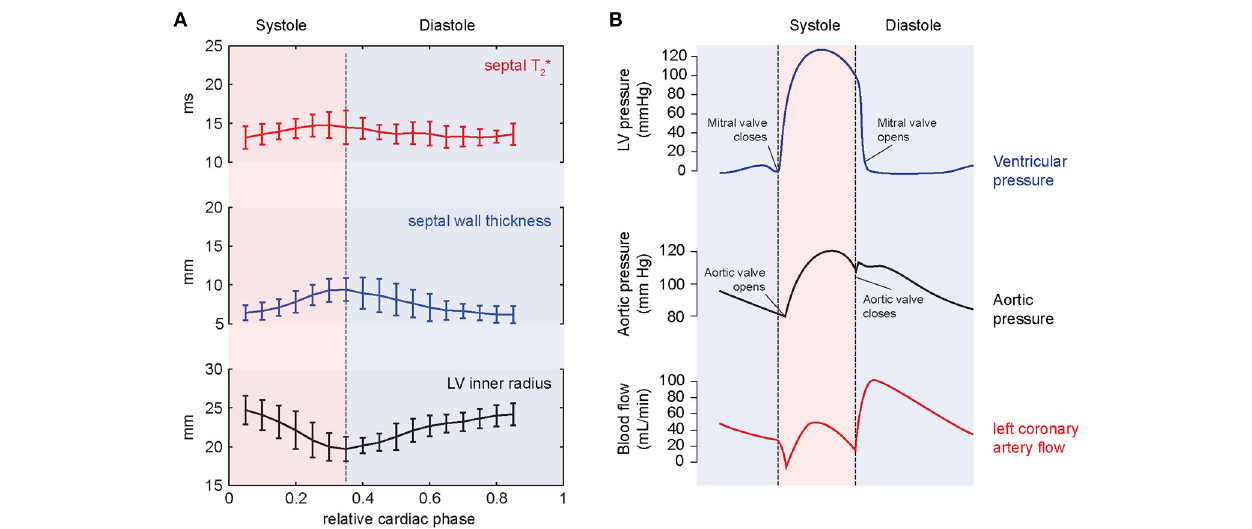
FIGURE 12 | Results of temporally resolved myocardial T 2 * mapping in healthy volunteers at 7.0 T. (A) Course of mean septal T 2 * , wall thickness and LV inner radius plotted over the cardiac cycle averaged for a group of healthy volunteers. Error bars indicate SD. Myocardial T 2 * changes periodically across the cardiac cycle increasing in systole and decreasing in diastole. (B) The periodic T 2 * changes can be explained by cyclic variations of myocardial blood volume fraction related to differences in blood pressure and myocardial wall stress. The massive pressure increase in the left ventricle in the beginning of systole results in high myocardial wall stress compressing the myocardial vessels leading to a reduced blood supply to the myocardium while blood contained in the tissue is squeezed out. The resulting reduced myocardial blood volume fraction explains the systolic T 2 * increase, which cannot be explained by increased